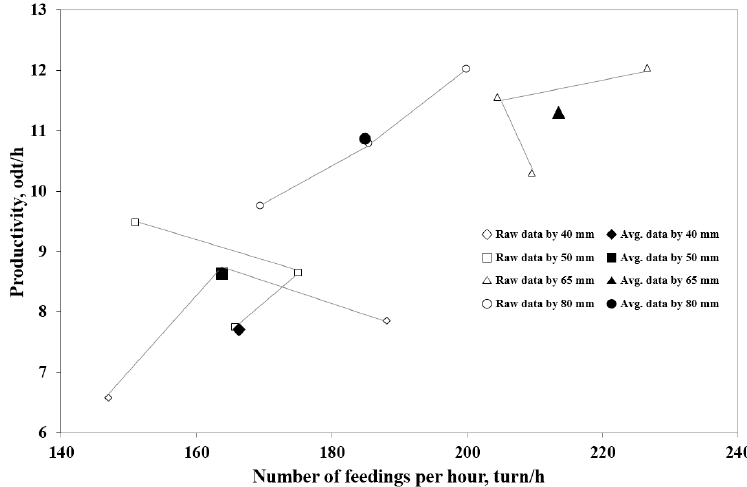
Figure 6. Analysis of the productivity of chipping by the number of feedings per hour and screen size.